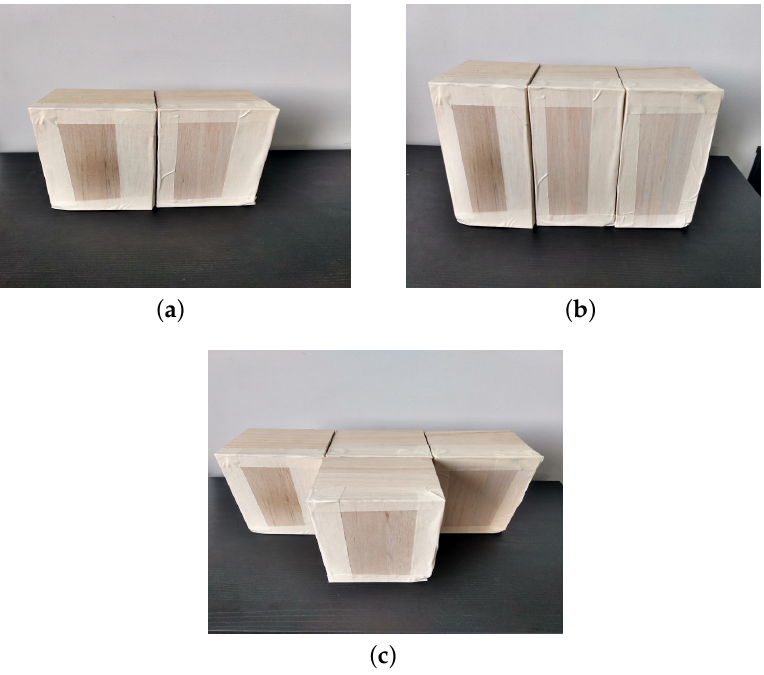
Figure 11. Thermal zones for cases 2, 3 and 4 with internal heating load. ( a ) Case 1. ( b ) Case 2. ( c ) Case